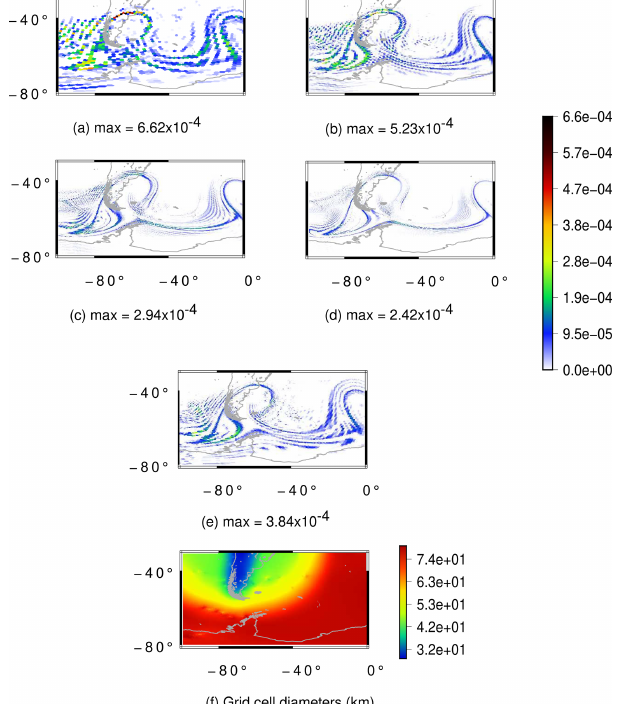
Figure 20. Flow over a mountain test case for the moist shallow- water model: rain field at day 30 for the grids UR6 (a) , UR7 (b) , UR8 (c) , UR9 (d) and VR7 (e) as well as the cell diameters in kilo- meters for the VR7 grid (f) . The UR6, UR7, UR8 and UR9 grids have an average resolution of 120, 60, 30 and 15km,